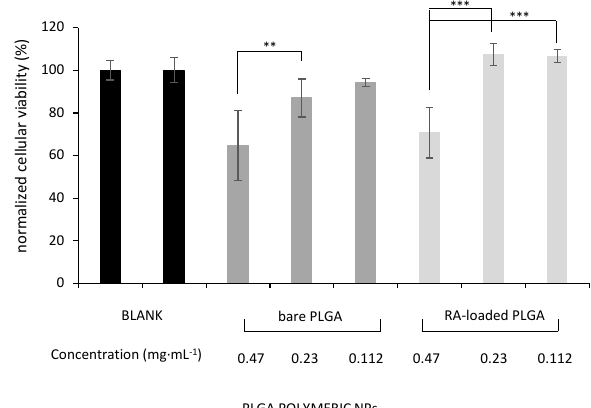
Figure 5. Cellular viability of SH-SY5Y cells upon treatment with increasing concentrations of PLGA polymeric NPs: non-loaded (bare) and RA-loaded PLGA NPs at 37 °C for 24 h. Cellular viability corresponds to the ratio between non-treated and treated cells. The first blank corresponds to untreated cells and the second one corresponds to the incubation of untreated cells with PBS. Data are average ± SD of three independent experiments (** p < 0.005 and *** p < 0.001).